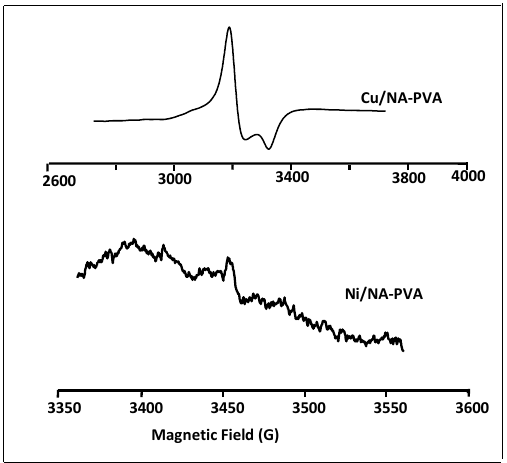
Figure 4. EPR spectra of Ni/PVA-NA and Cu/PVA-NA copolymer samples.